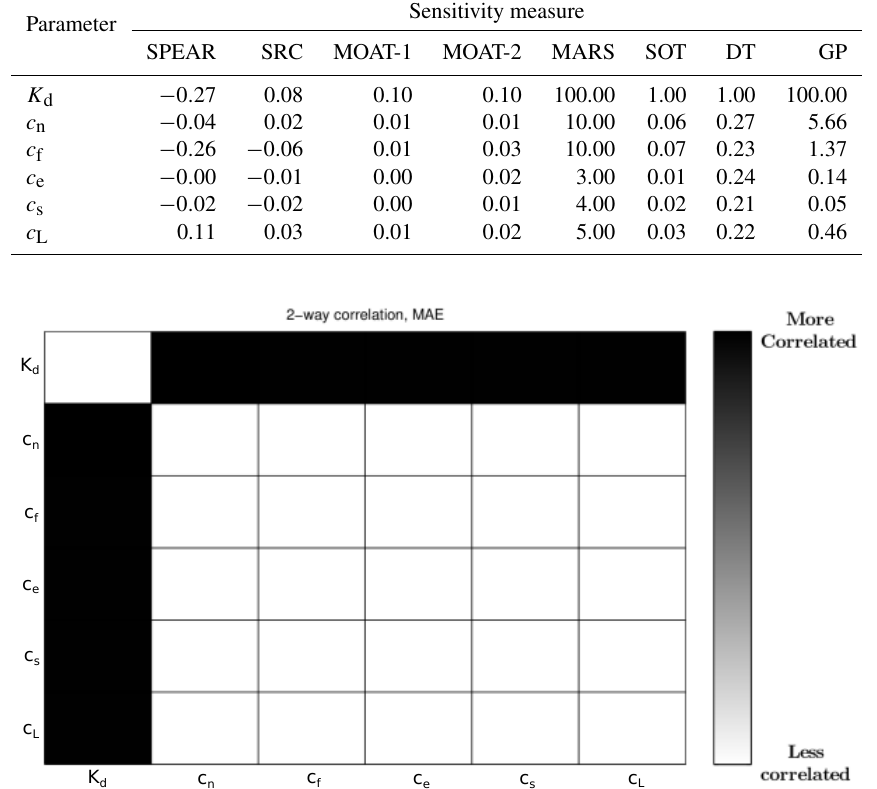
Table 4. Parameter sensitivity rankings of different qualitative sensitivity analysis methods. Parameter